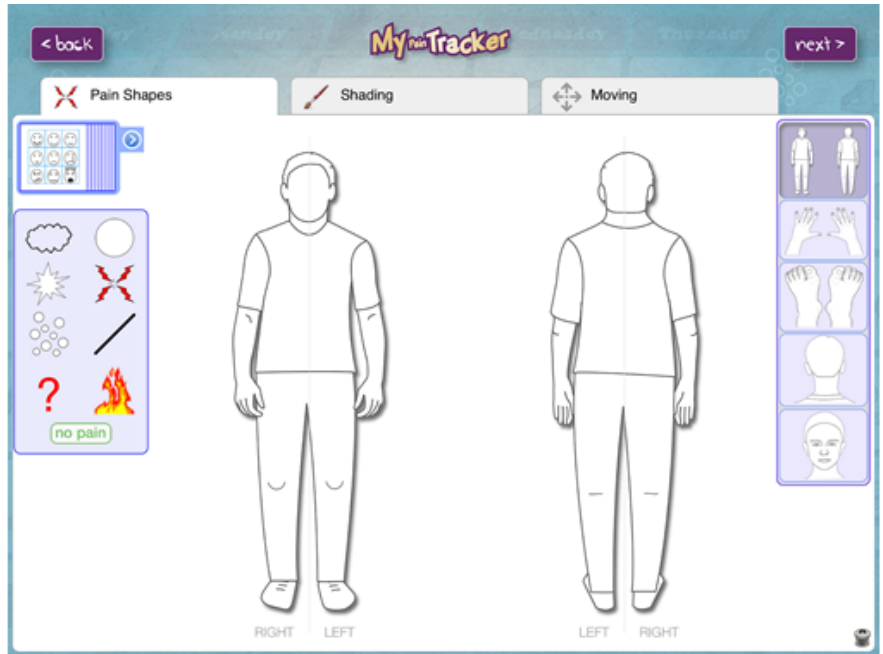
Figure 1. Screenshot of the My Pain Tracker main user